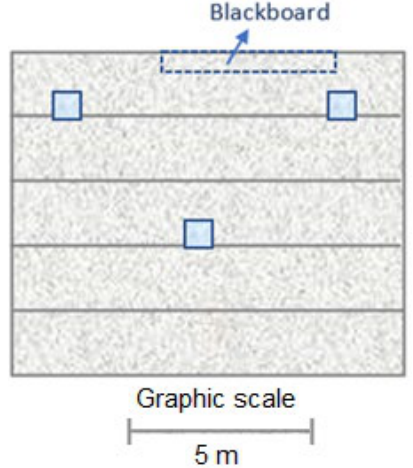
Figure 8. Scale model of the single axis polar heliostats proposed by authors based on Torres et al. (2015). ( a ) Heliostat mechanism used. ( b ) Sectioning of the mechanism used. ( c ) Overall operating principle of the heliostat (blue arrows represent the elementary movements of the primary mirror).